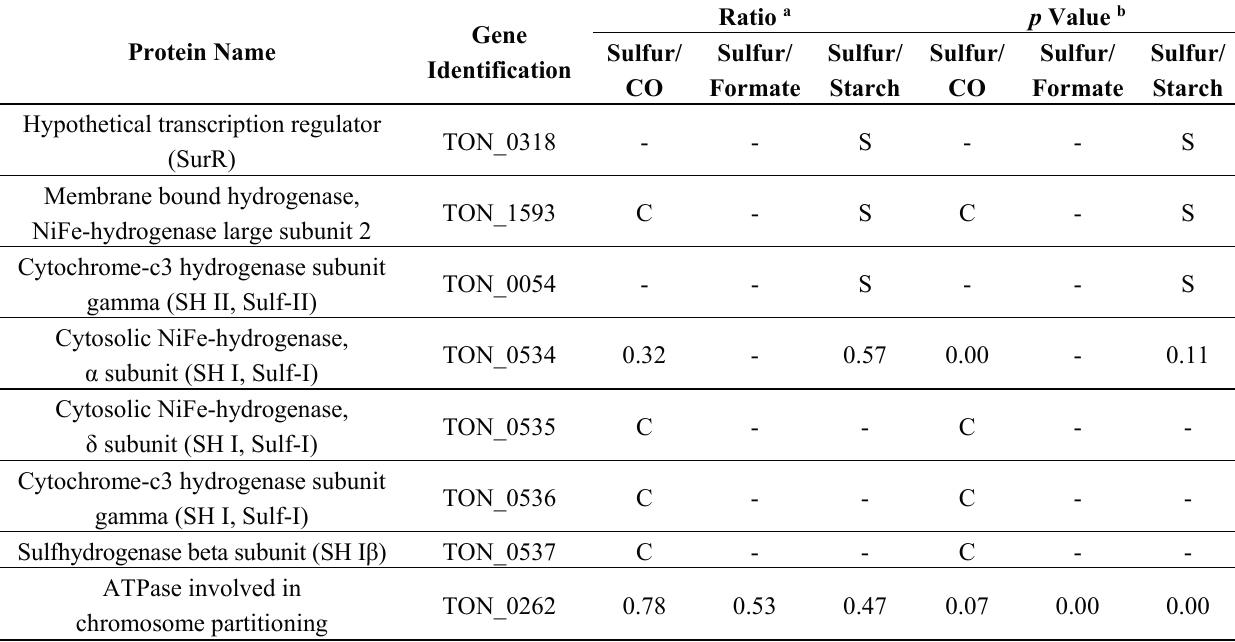
Table 3. Relative abundance of representative down-regulated proteins in T. onnurineus NA1 cells grown on sulfur compared with those grown on CO, formate, and starch (Y, only detected in Sulfur; S, only detected in Starch; C, only detected in CO; F, only detected in Formate; -, none detected in this